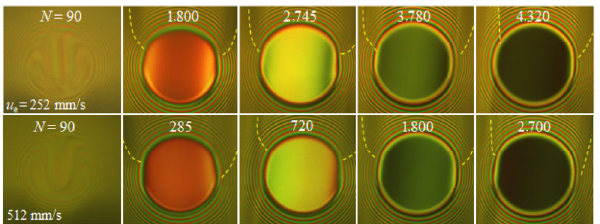
Fig. 9 Evolutions of grease films with disc revolutions, Grease